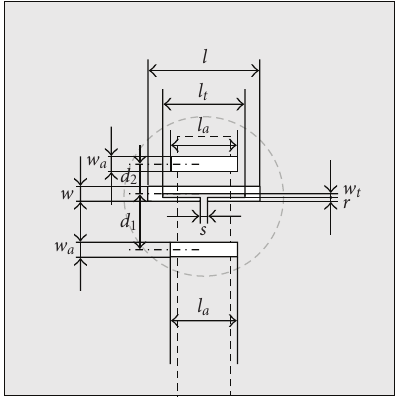
Figure 7: Geometry of the modified slot coupling with two additional parallel slots.